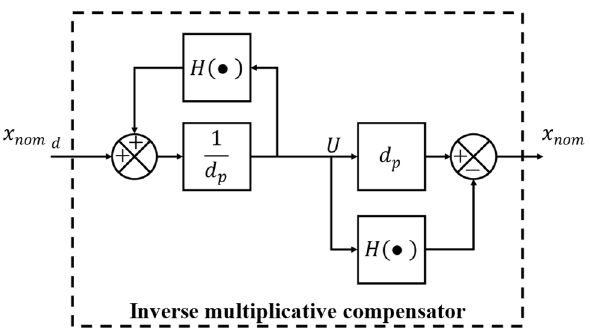
Figure 5. Inverse multiplicative hysteresis compensation diagram for the PEAs.